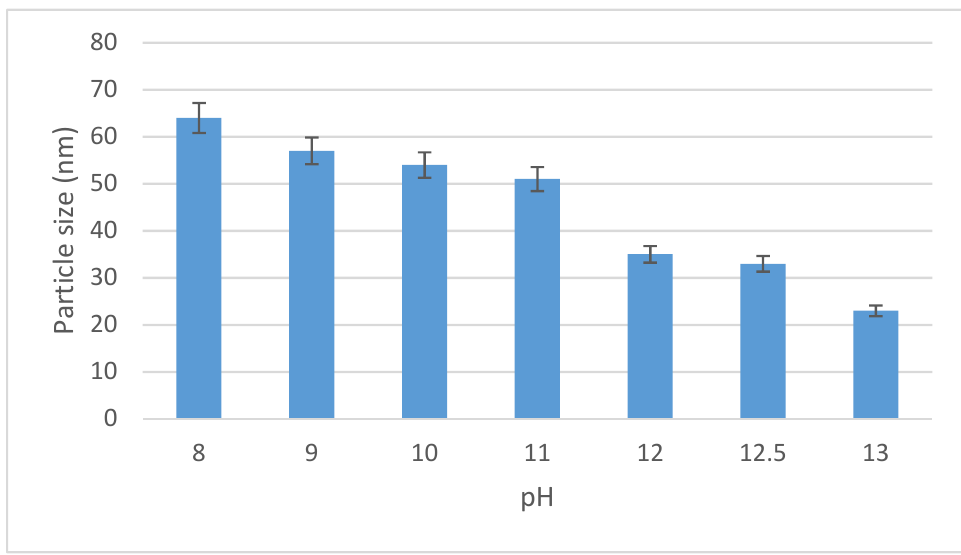
Figure 2. Particle size distribution of synthesized Ag-NPs vs. pH. (c) Scanning electron microscopy, SEM, and studies (c) To investigate the large-scale morphology of Ag-NPs, the samples synthesized at different pH values were characterized by scanning electron microscopy, SEM (Figure